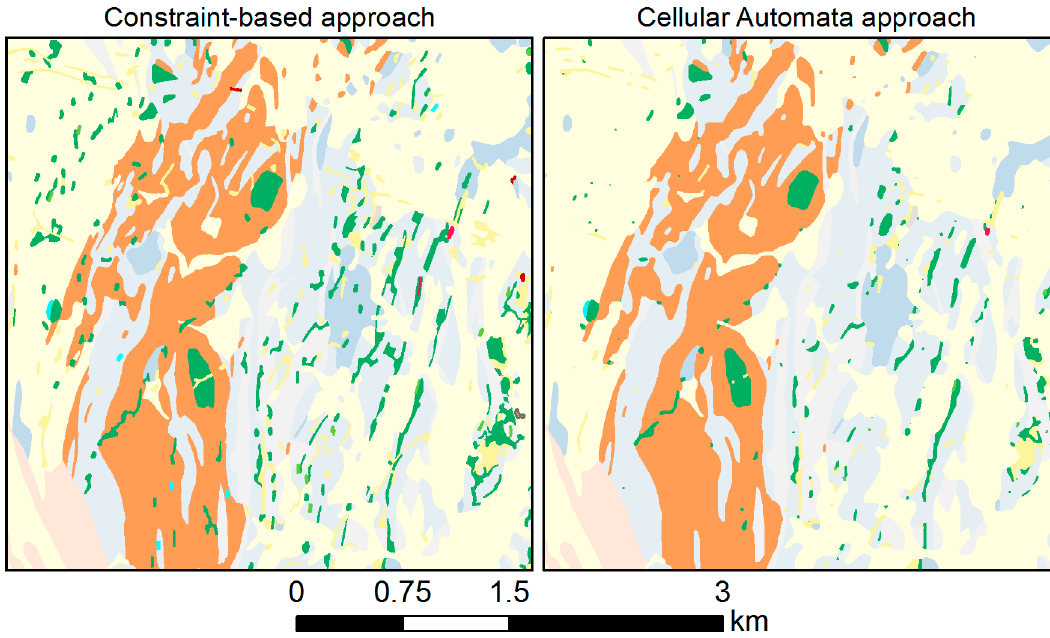
Figure 17. Comparison of two approaches: Constraint-based approach (left) and the cellular automata solution generated in GeoScaler (right).